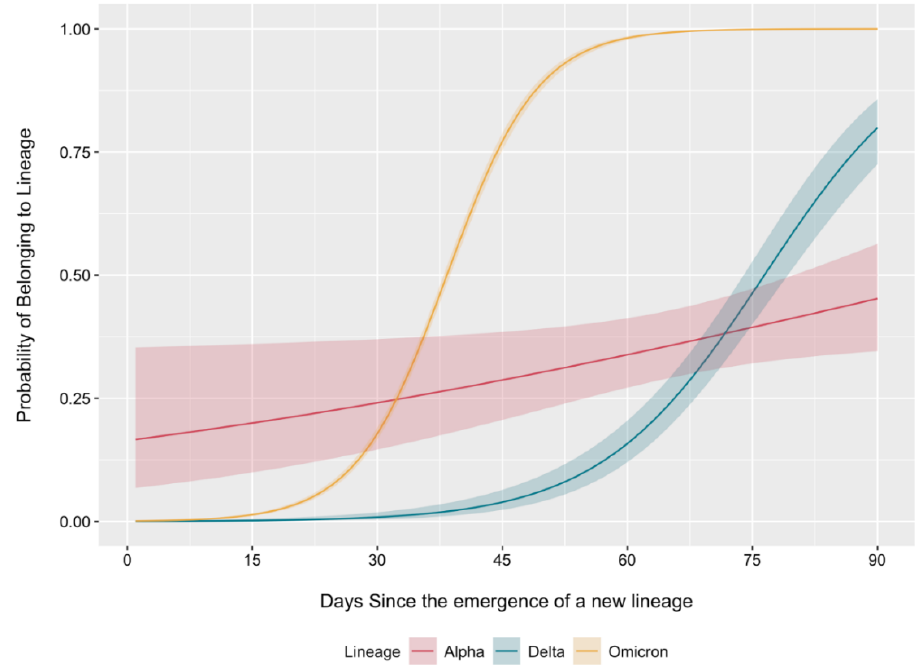
Figure 3. Binomial logistic regression for predicting the probability of sequenced sequences belonging to the variant of interest. The analysis was restricted to the first 90 days from the occurrence of each variant. Lines are plotted with 95% confidence intervals.